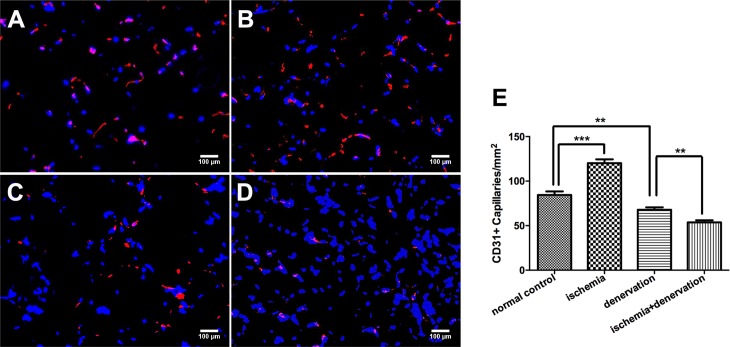
CD31 positive capillary density.Capillary density was evaluated using immunostaining for CD31 of tibialis anterior muscle sections in group NC (A), HI (B), HD (C) and HID (D) on day 28 post-surgery and quantified by counting CD31 positive capillaries per square millimeter. The bar graph shows the capillary density (E). Red indicates CD31, and blue indicates nuclei. ** p<0.01, *** p< 0.001.